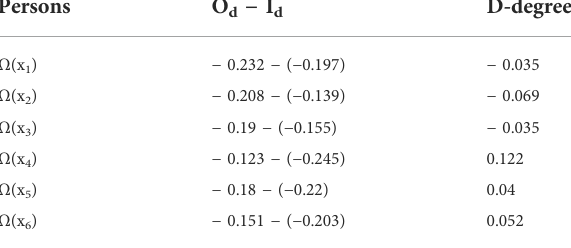
TABLE 8 Domination degree of every person.